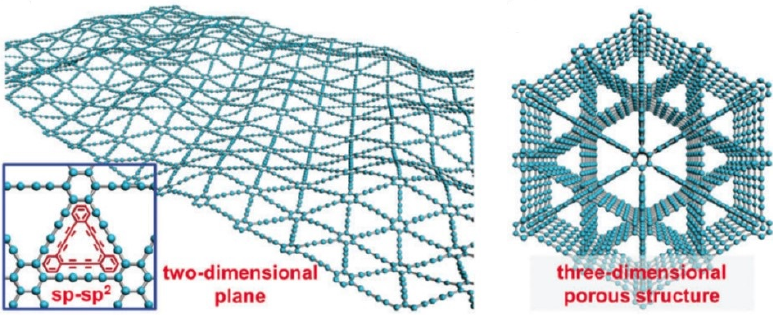
Figure 26. Structural features of graphdiyne (GDY). Reproduced from [98], with permission from the Royal Society of Chemistry, copyright